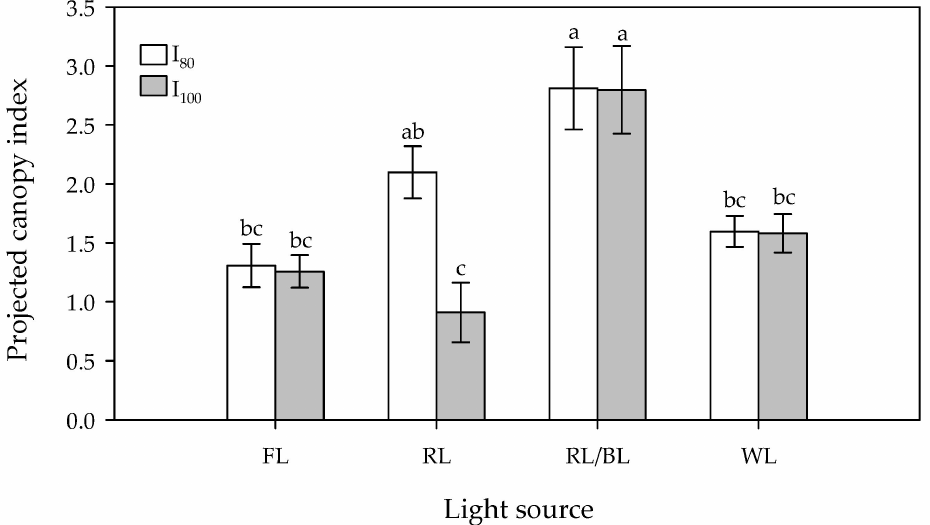
Figure 3. Effect of light source (FL = Fluorescence, RL = predominantly Red, RL/BL = Red/Blue, and WL = White lights) and light intensity (I 80 and I 100 = 80 and 100 µ mol m − 2 s − 1 , respectively) on in vitro projected canopy index. Different letters indicate significant differences for p < 0.05, error bars indicate standard error of the